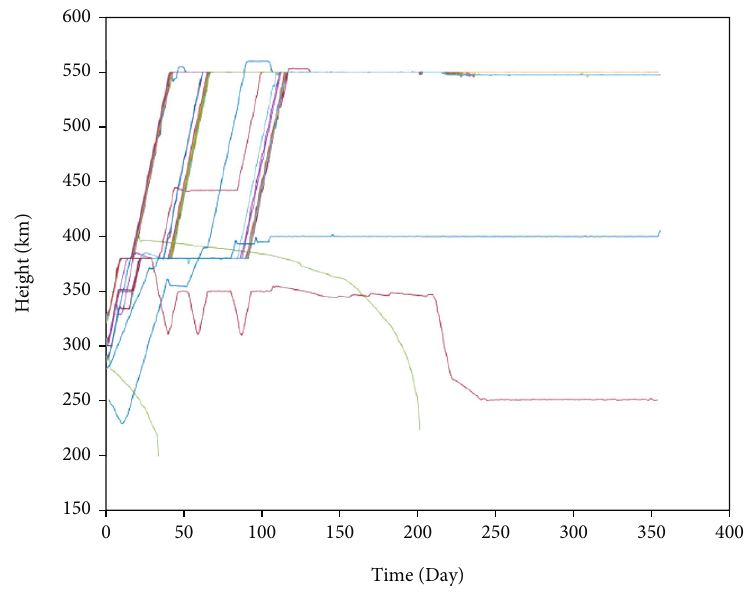
Figure 10: Initialization of height.